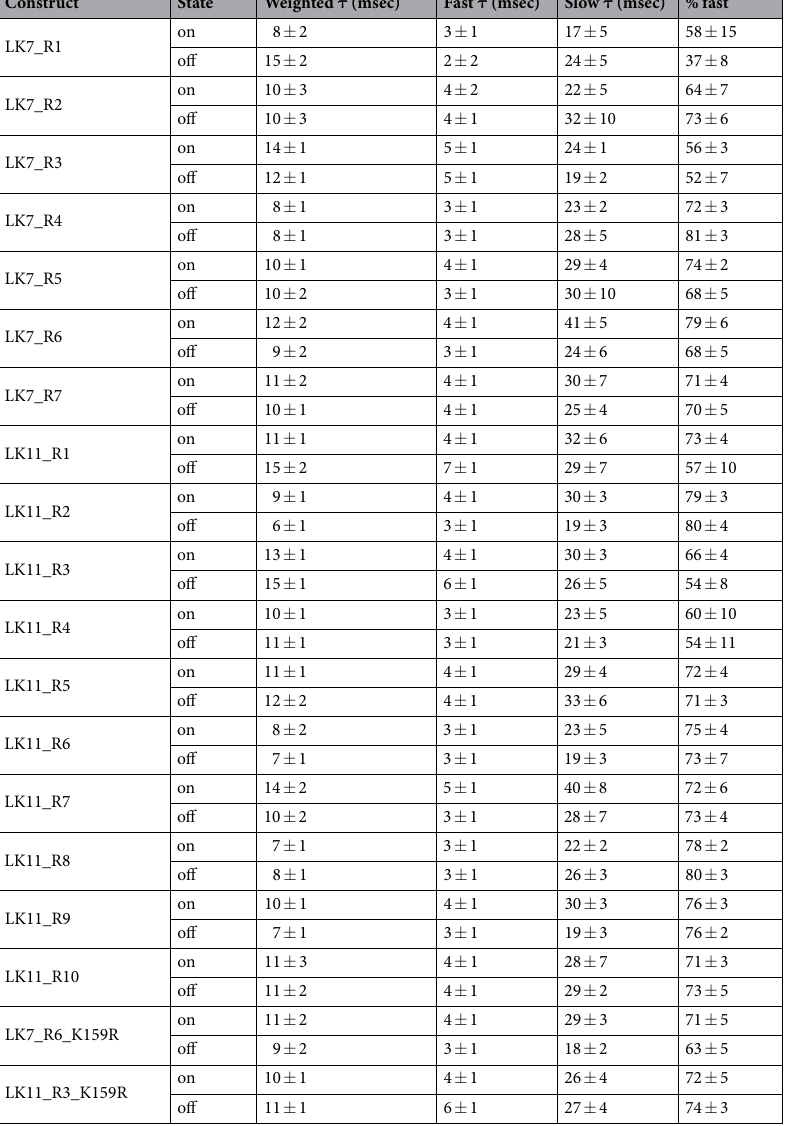
Table 2. Physical properties of the arginine scan series of constructs.